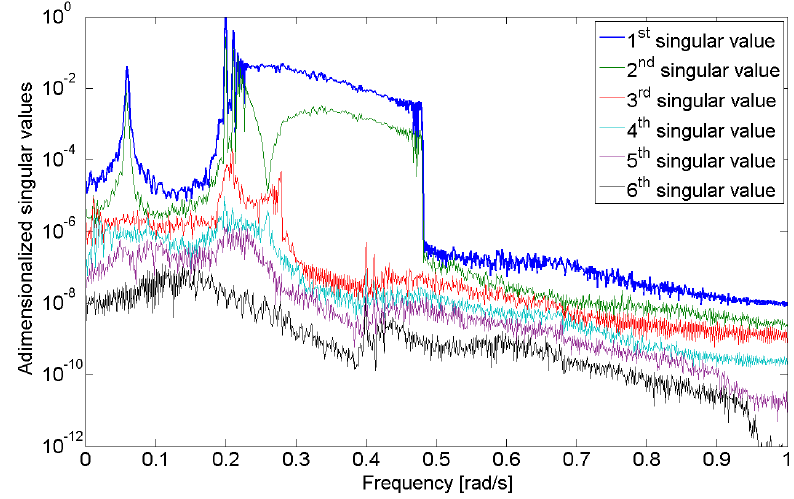
Figure 5. Singular value plot for the first combination of damping ratios (case 1) in close to resonance wave conditions.